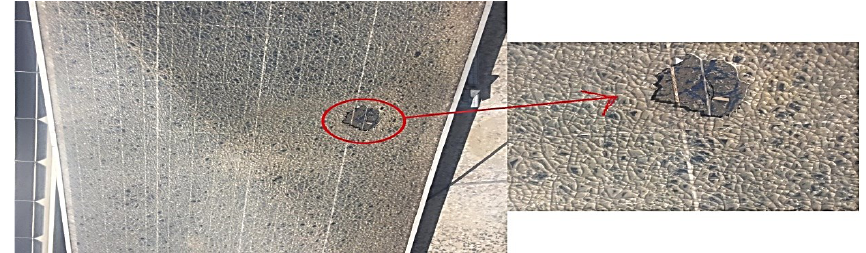
Figure 2. Glass protection breakdown-PV module Located in Islamabad, Pakistan.